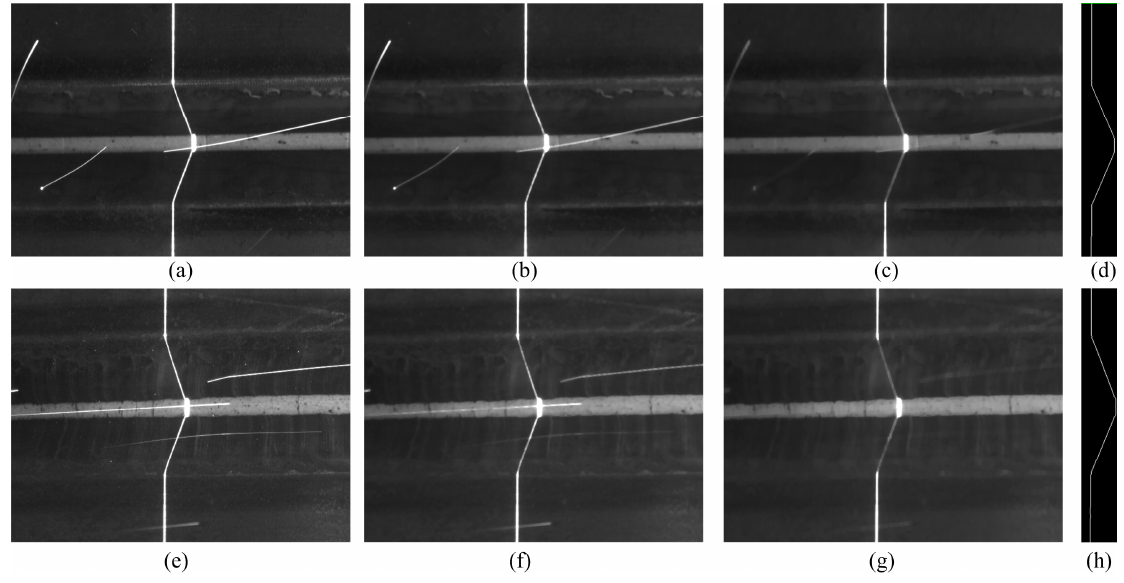
Figure 21. ( a , e ) the original image with splash and arc light, ( b , f ) the image after median filter, ( c , g ) The image after open operation, and ( d , h ) the process result.